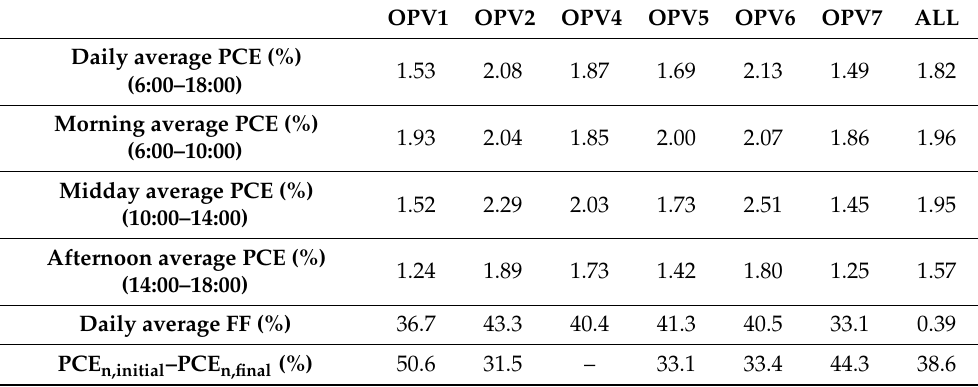
Table 2. Average PCE (%), FF (%), and normalized PCE loss (PCE n,initial —PCE n,final , %) of the greenhouse-deployed OPV arrays between 28.10.2019 to 19.2.2020. Measurement details for normal- ized PCE values are provided Section